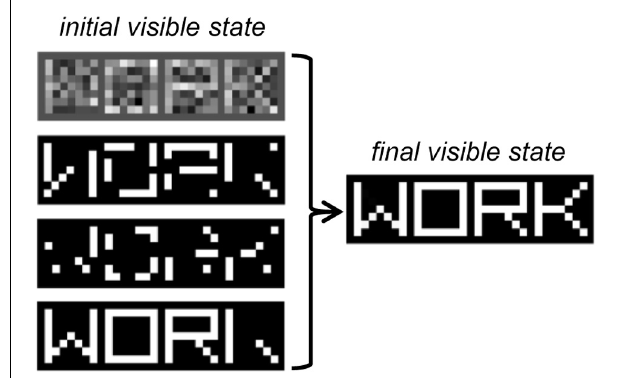
FIGURE 7 | Inference in the word perception DBN when the word image “WORK” is presented as input under different types of noise. From top to bottom: Gaussian noise, binary noise (30%), binary noise, (50%), occlusion noise. The final state of the visible units, identical across the four noise conditions, is shown on the